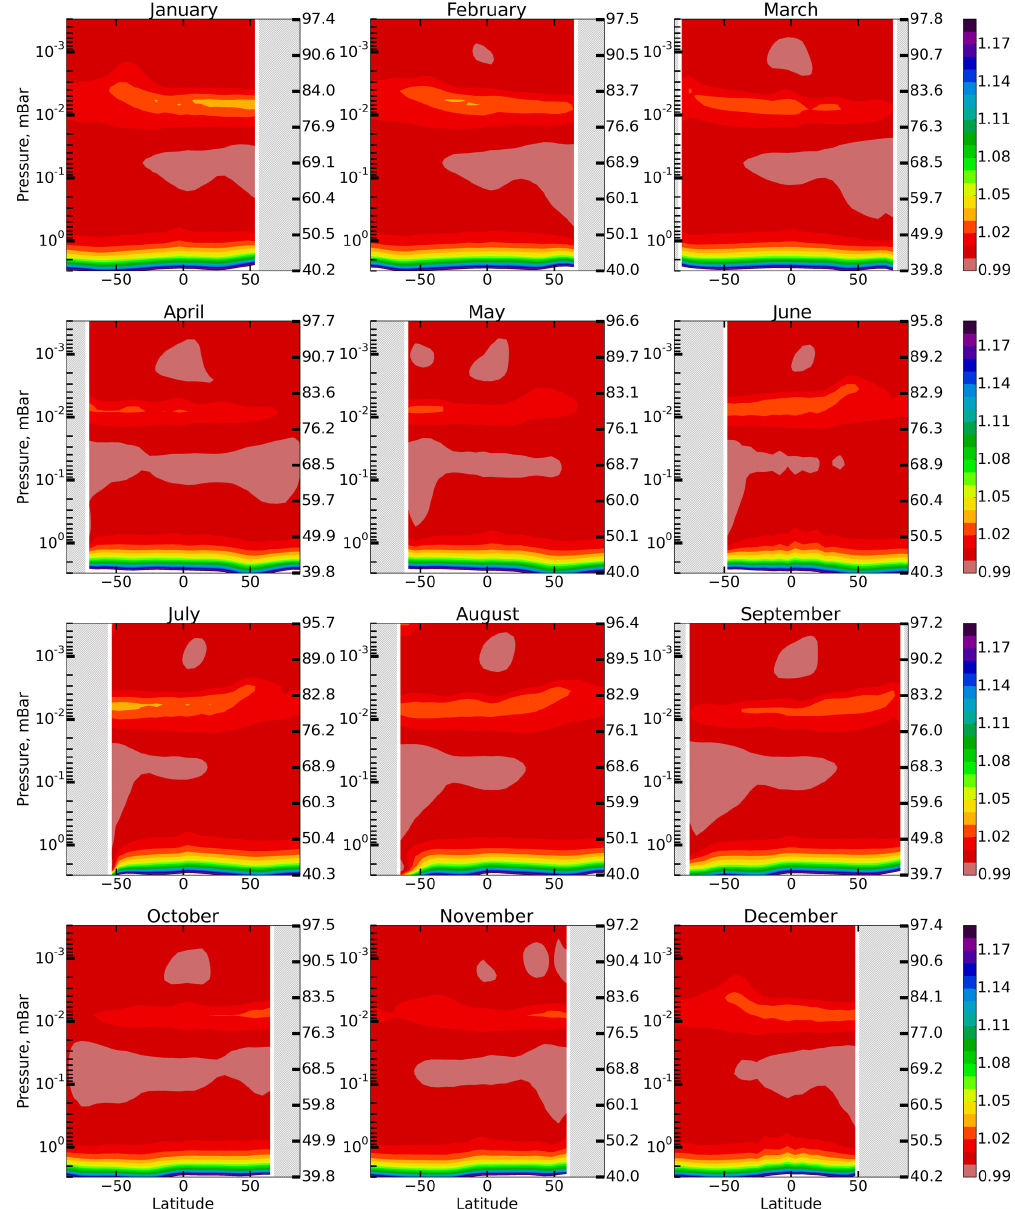
Figure 1. Daytime monthly averaged zonal mean F